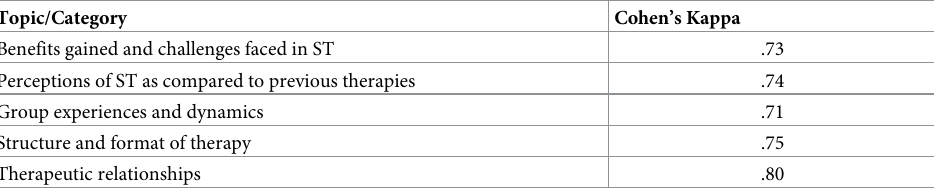
Table 2. Inter-coder agreement for each